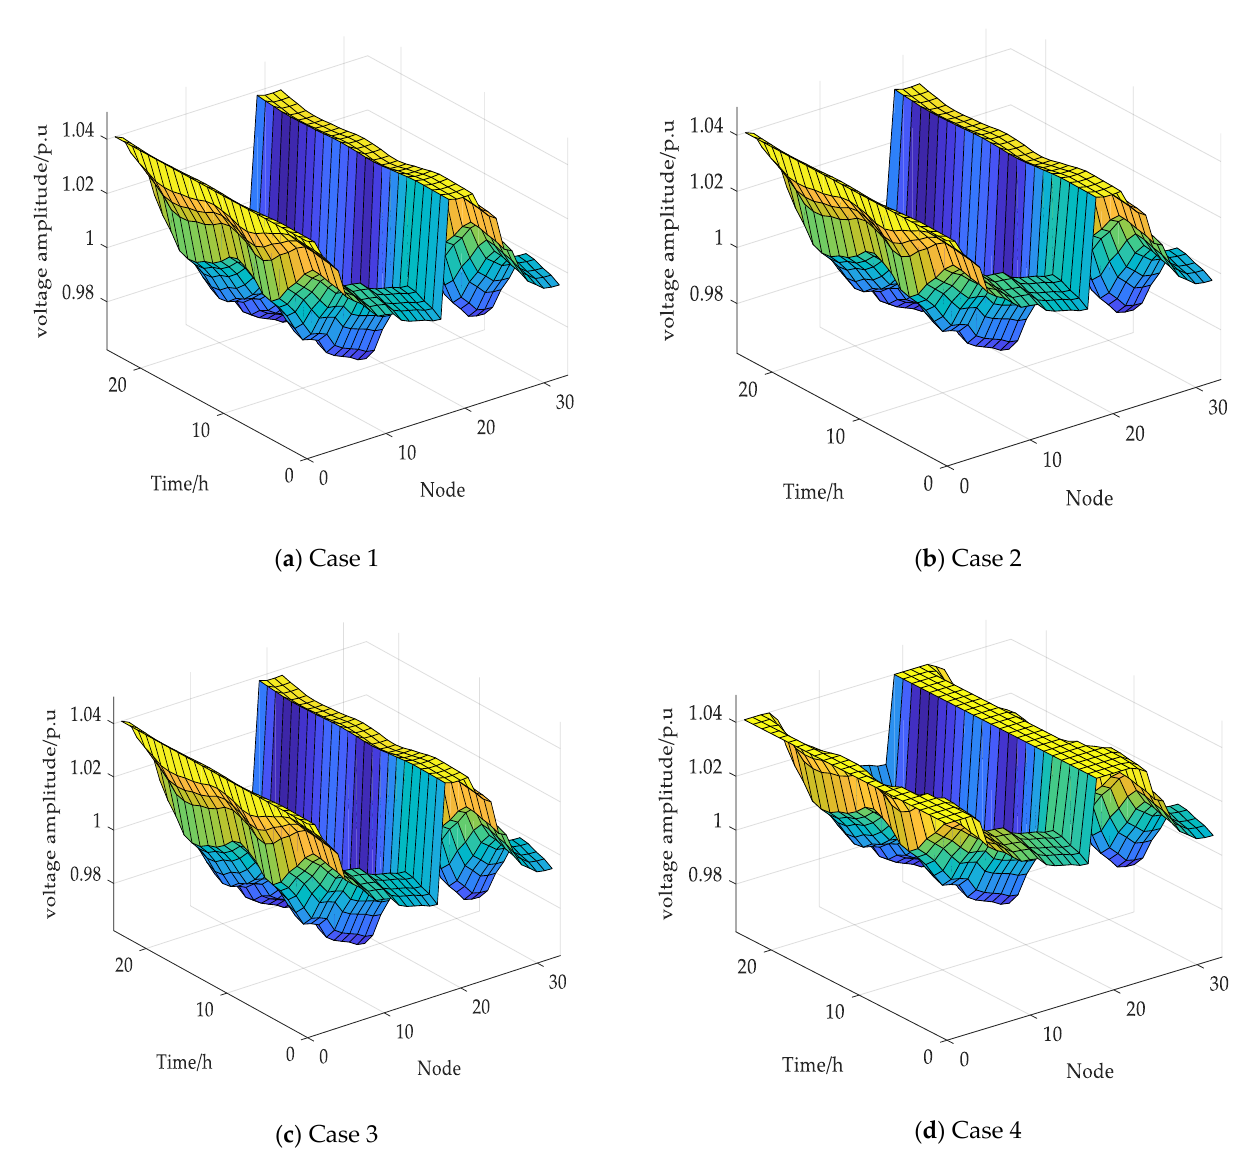
Figure 11. The voltage amplitude of different